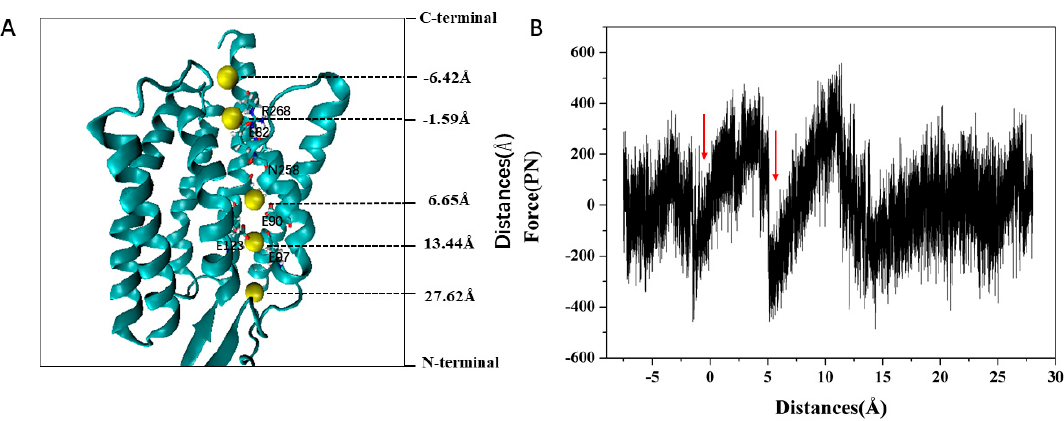
Figure 9. ( A ) The simulated trajectory of ion permeation through channels. Na + is represented by the yellow sphere. ( B ) The force received varies with the reaction coordinates during ion pulling in the ChR2-cis system. The vertical arrow indicates the Z position of the force local minima.